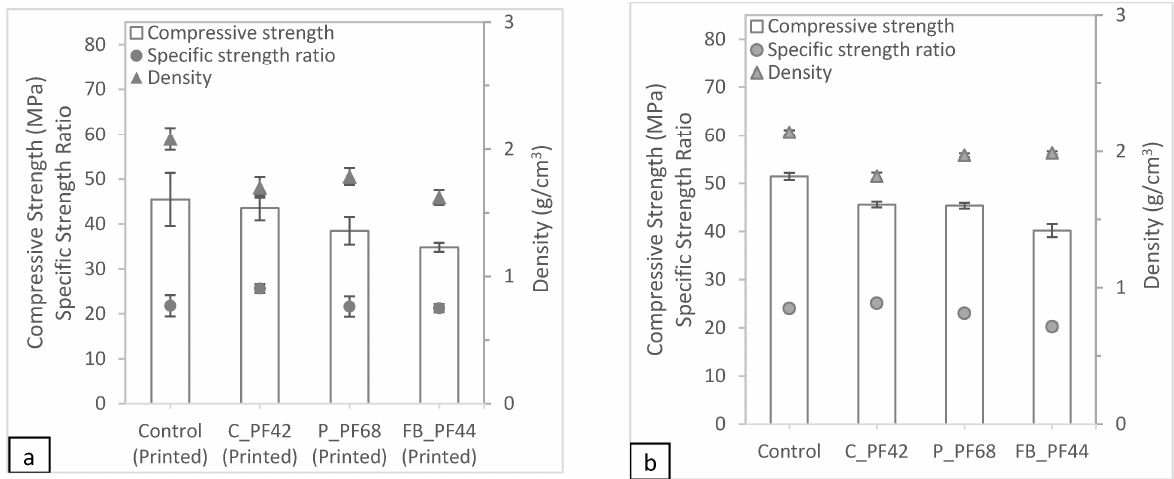
Figure 11. Compressive test results for the optimized ( a ) printed and ( b ) cast